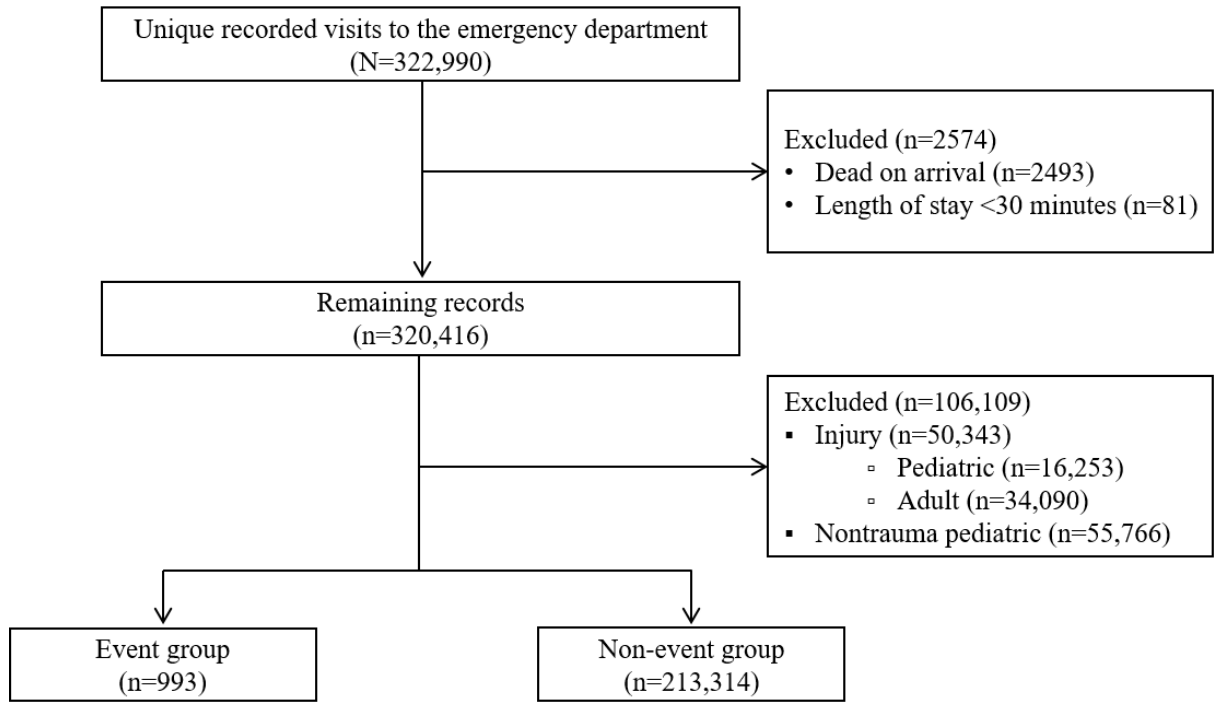
Figure 1. Flow diagram for the selection of the study cohort. Data were processed as unique records based on the date on which a patient visited the emergency department and may correspond to the same